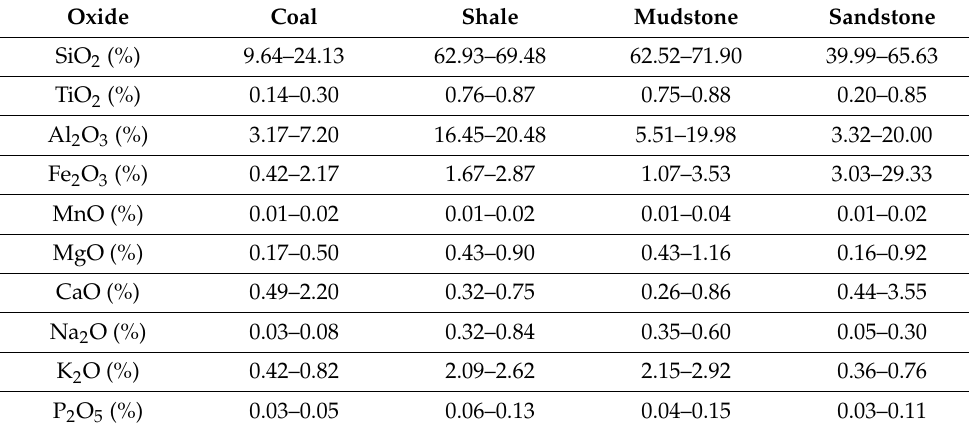
Table 2. Abundances of the oxides in studied samples.